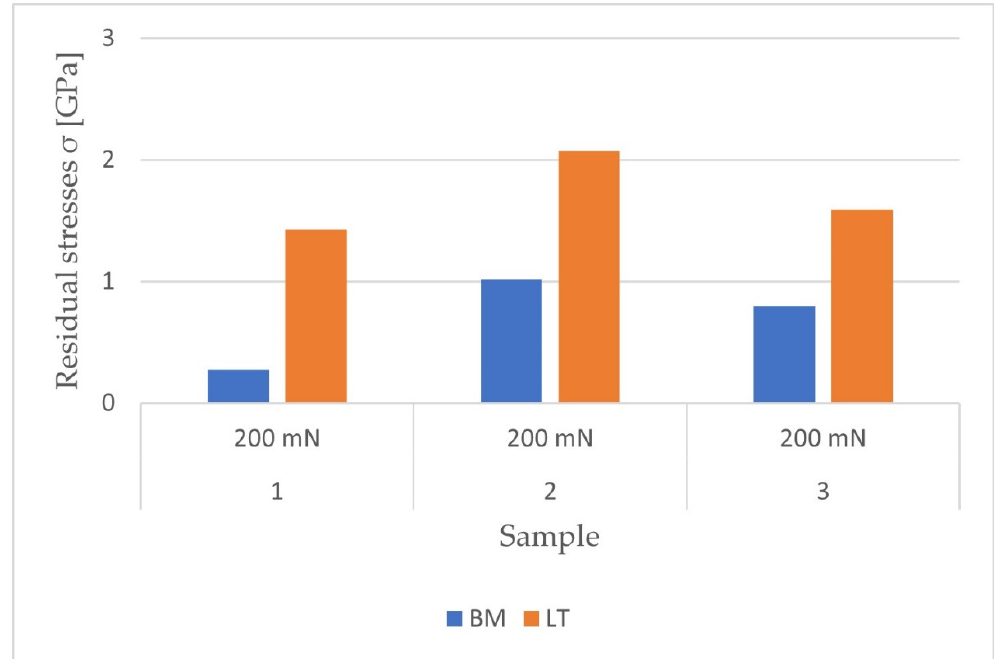
Figure 12. Residual stresses obtained at a depth of 1000 nm from the surface of the materials. The obtained results indicate an increase in residual tensile stress after remelting. By